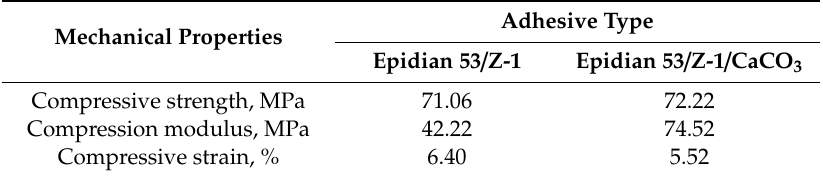
Table 5. Compressive strength of the reference samples of Epidian 53/Z-1 and Epidian 53/Z-